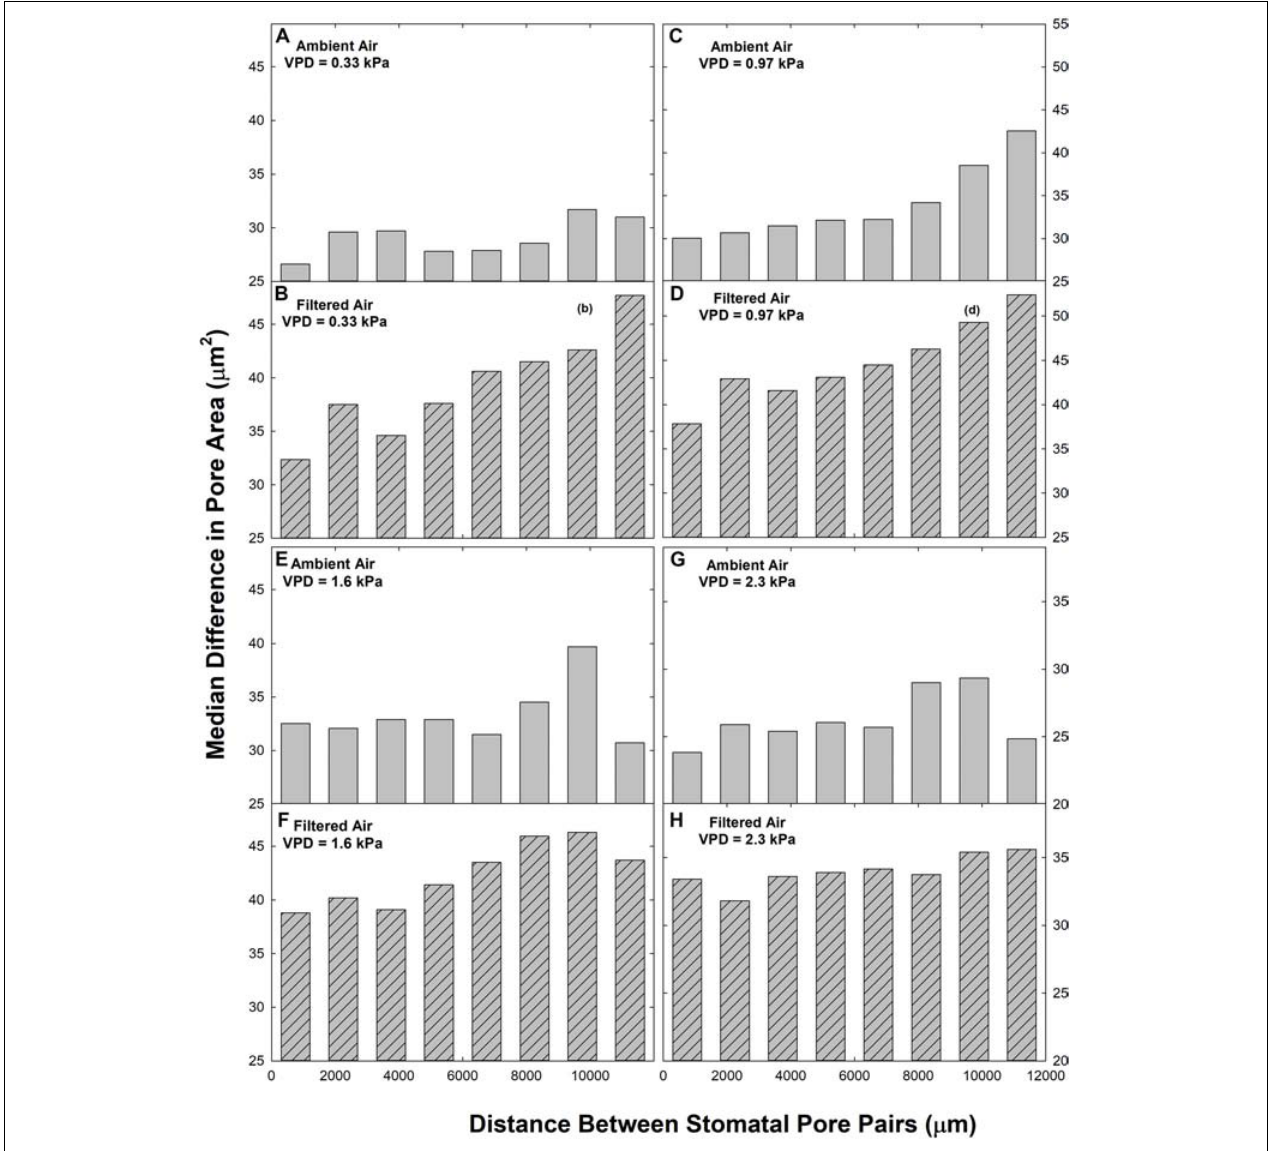
FIGURE 7 | Relationships between the paired difference between pore area ( (cid:49) A) and the distance separating the pores (d) in ambient air (AA; gray bars; A,C,E,G ) and filtered air (FA; hatched bars, B,D,F,H ) at different levels of evaporative demand (VPD), presented as median. Distance classes as in Figure 2